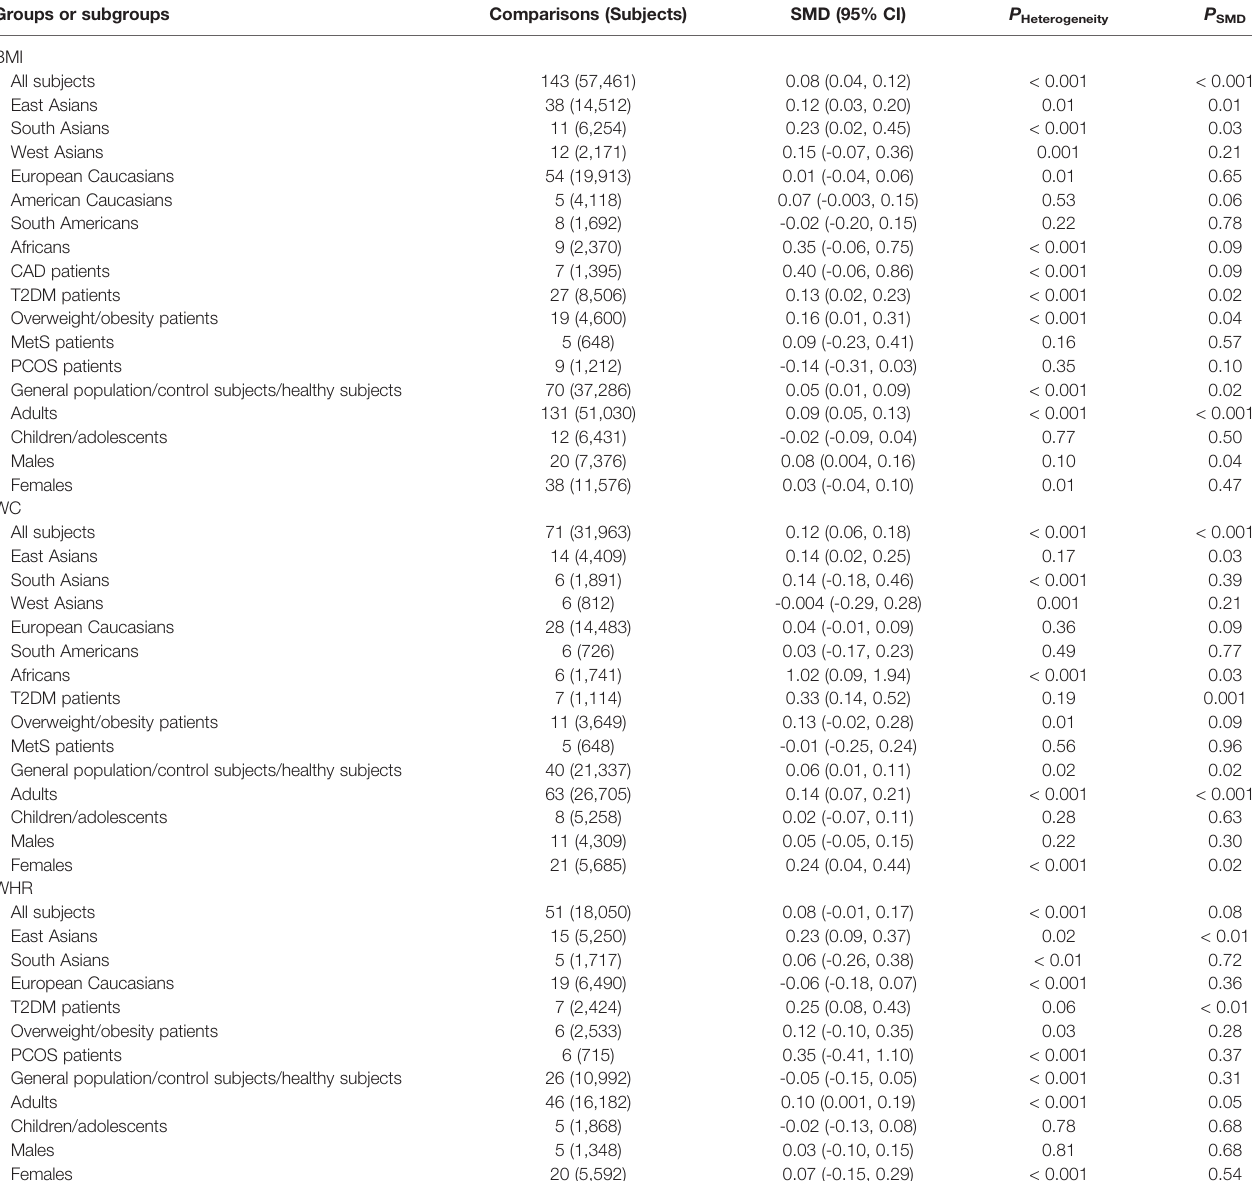
TABLE 1 | Meta-analysis between the rs1801282 polymorphism in PPARG and obesity indexes. Groups or